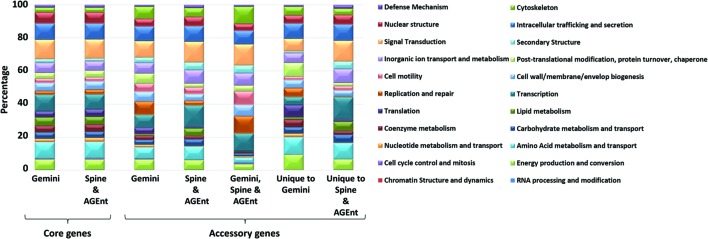
Functional distributions of P. aeruginosa LESB58 genes. The distribution of genes identified either core or accessory by GEMINI, & Spine and AGEnt (Ozer et al., 2014).